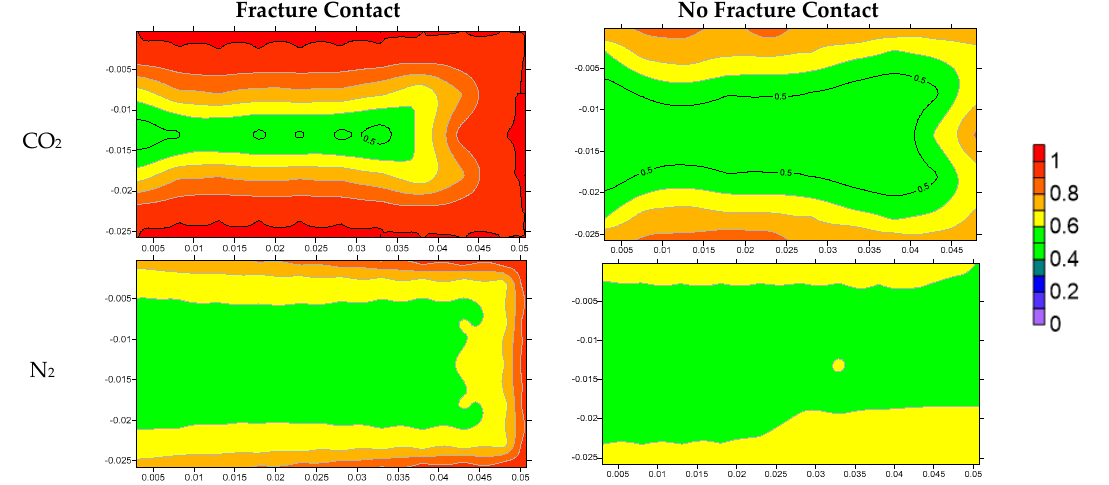
Figure 13. Mole fraction of injection fluid in oil in Case-4 in soaking process (ij profile).